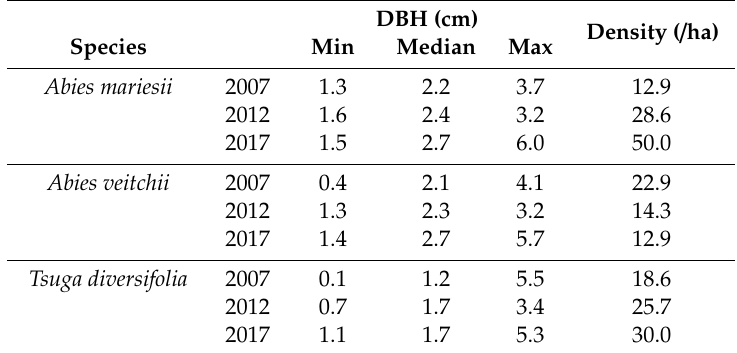
Table 1. Size and density of new recruits.